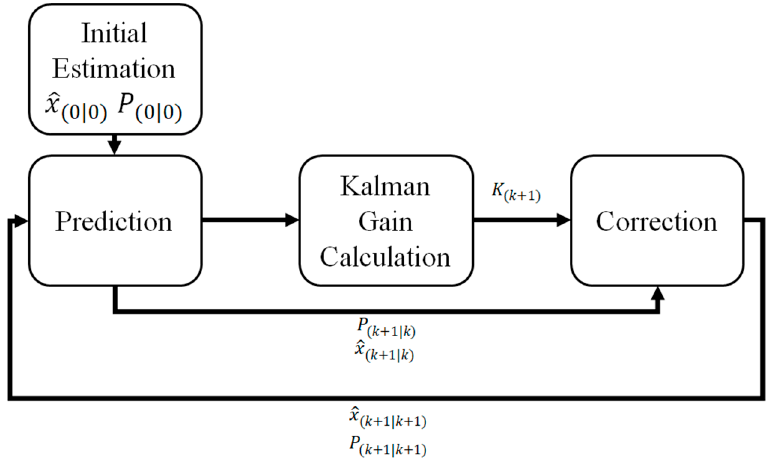
Figure 3. Recursive structure algorithm of the Kalman filter. A simulation was performed using virtual, synthesized signals to verify the filtering performance of the Kalman filter. As shown in Figure 4a, the signal is in the shape of a sine wave between 0.001 and 0.004 s. Beyond this period, the true signal has a value of zero. Signals other than the true signal include Gaussian noise and ripple voltage signals. Figure 4b shows a signal in the shape of a triangular wave. This signal represents a combined signal of the ripple voltage signal and Gaussian noise. Combining the true signal with the Gaussian noise and the ripple voltage signal generates the signal shown in Figure 4c. This signal was assumed to be the measured signal. The Kalman filter described earlier was applied to the artificially synthesized and measured signal, and the result is shown in Figure 4d. The blue line denotes 0.1 as the value of Q, and the red line denotes 1.0 × 10 − 5 as the value of Q. If the value of Q increases, the predicted value of the error covariance increases. When the predicted value of the error covariance increases, the Kalman gain increases accordingly, this result reflects the measured value to a greater degree. Therefore, as the value of Q decreases, only the values between 0.001 and 0.004 s, which is the interval within which the true signal has non-zero values, decrease while the values in the other intervals do not change. Thus, it was verified that the error due to the ripple voltage signal is very significant. The Kalman filter assumes that the noise is Gaussian. However, the ripple voltage signal is periodic, not a Gaussian noise. This discrepancy adversely affects the performance of predicting the true signal [34].